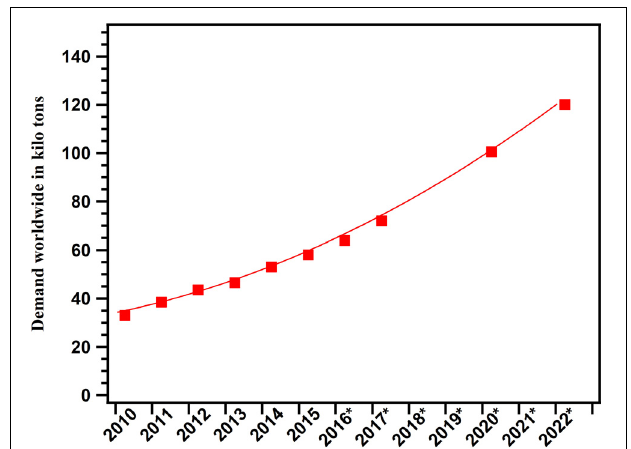
FIGURE 1 | Global demand for carbon fibers in kilo tons from 2010 to 2022. Data adapted from Fang et al. (2017a) with permission from The Royal Society of Chemistry (Order license ID: 1029647-1)